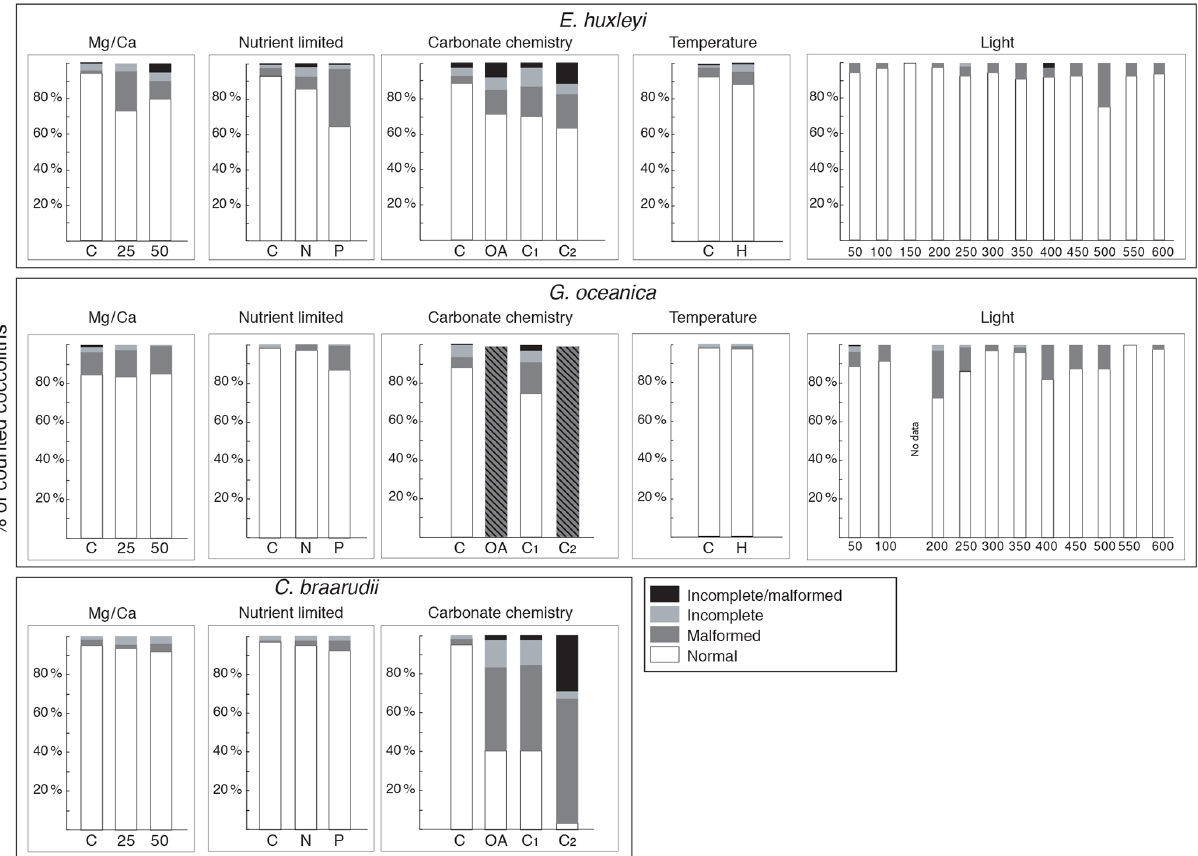
Figure 4. Percentage of normal, malformed, incomplete, and incomplete/malformed coccoliths versus experiments. The experiments dis- played represent Mg / Ca, nutrient limitation, carbonate chemistry, temperature, and light intensity manipulations. C. braarudii did not survive at high temperature (22.5 ◦ C), and no malformations were observed under the different light intensities tested; therefore, per- centage of malformations are not represented for these experiments for this species. Furthermore, no malformation was observed for P. carterae , and percentages are not shown. C: control treatment. Mg / Ca: calcium manipulation experiment; 25, [ Ca 2 + ] = 25mmolL − 1 ; 50, [ Ca 2 + ] = 50mmolL − 1 . Nutrient limited: nutrient limitation experiment; N: nitrogen-limited condition; P: phosphate-limited condition. Temperature experiment; H is for 22.5 ◦ C; carbonate chemistry experiment; theoretical CO 2 values: C: 400ppm; OA, ocean acidifica- tion: 1000ppm; C1, Cretaceous scenario1: 1000ppm; C2 Cretaceous scenario2: 3000ppm. Light: 12 different light intensities from 50 to 600µmphotonsm − 2 s − 1 . For every treatment and for every replicate 100 specimens were